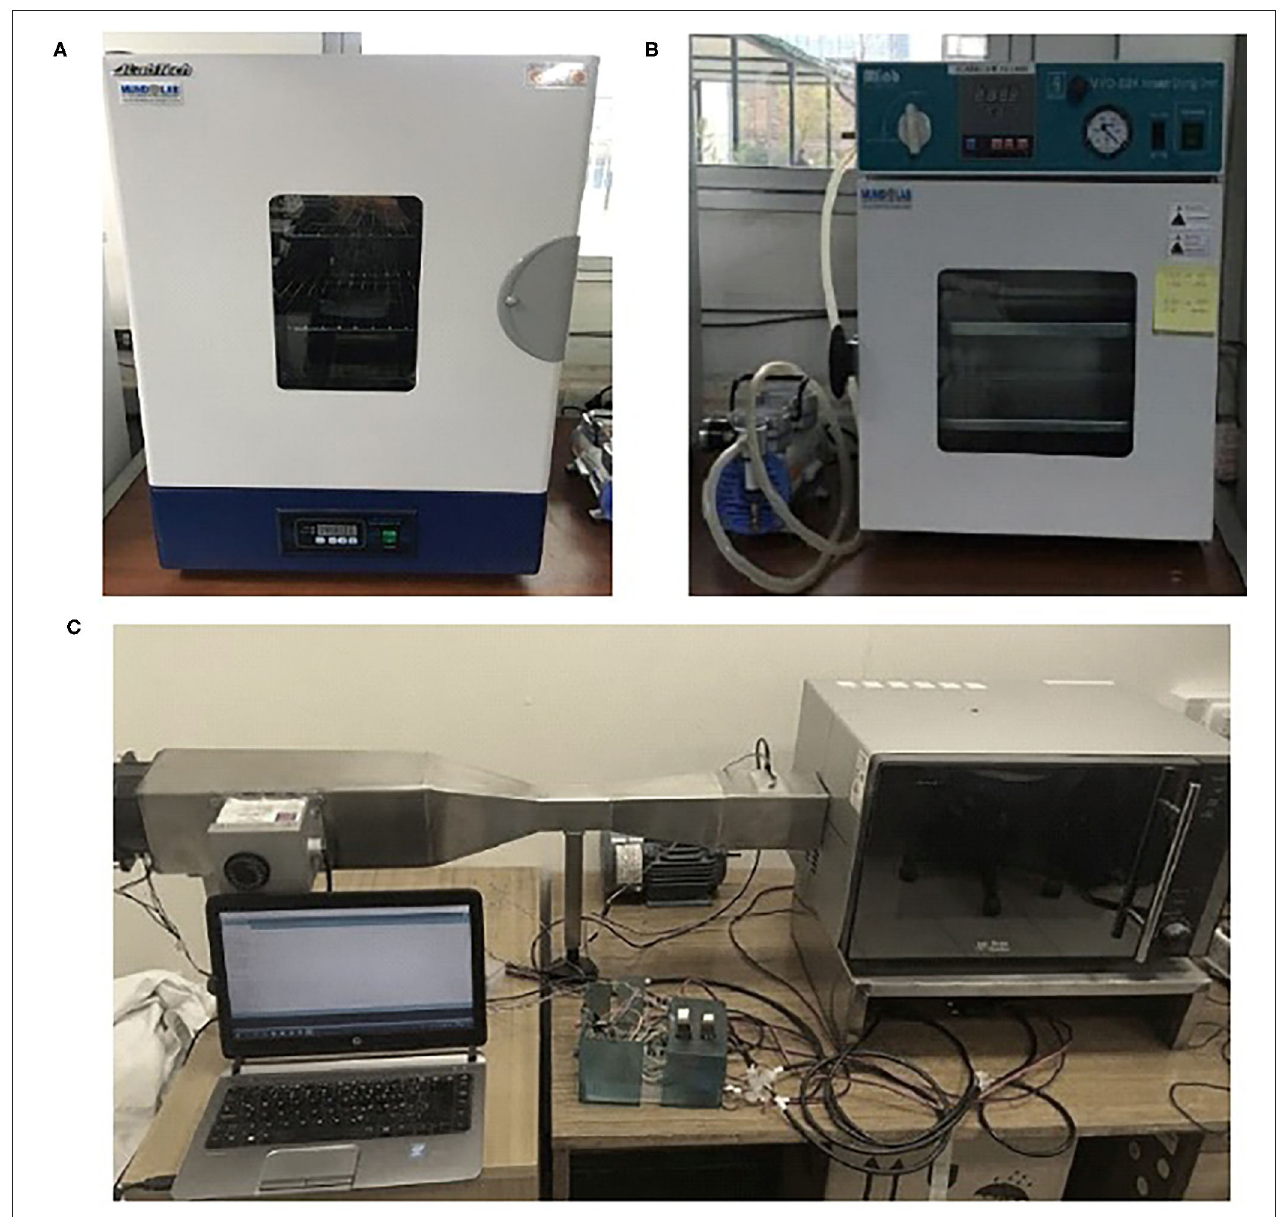
FIGURE 1 | Different dryers used for this study: (A) Oven dryer (NC), (B) vacuum dryer (VNC), and (C) convective (FC) and microwave-assisted convective dryer (MWFC) assisted convective dryer (MWCD).